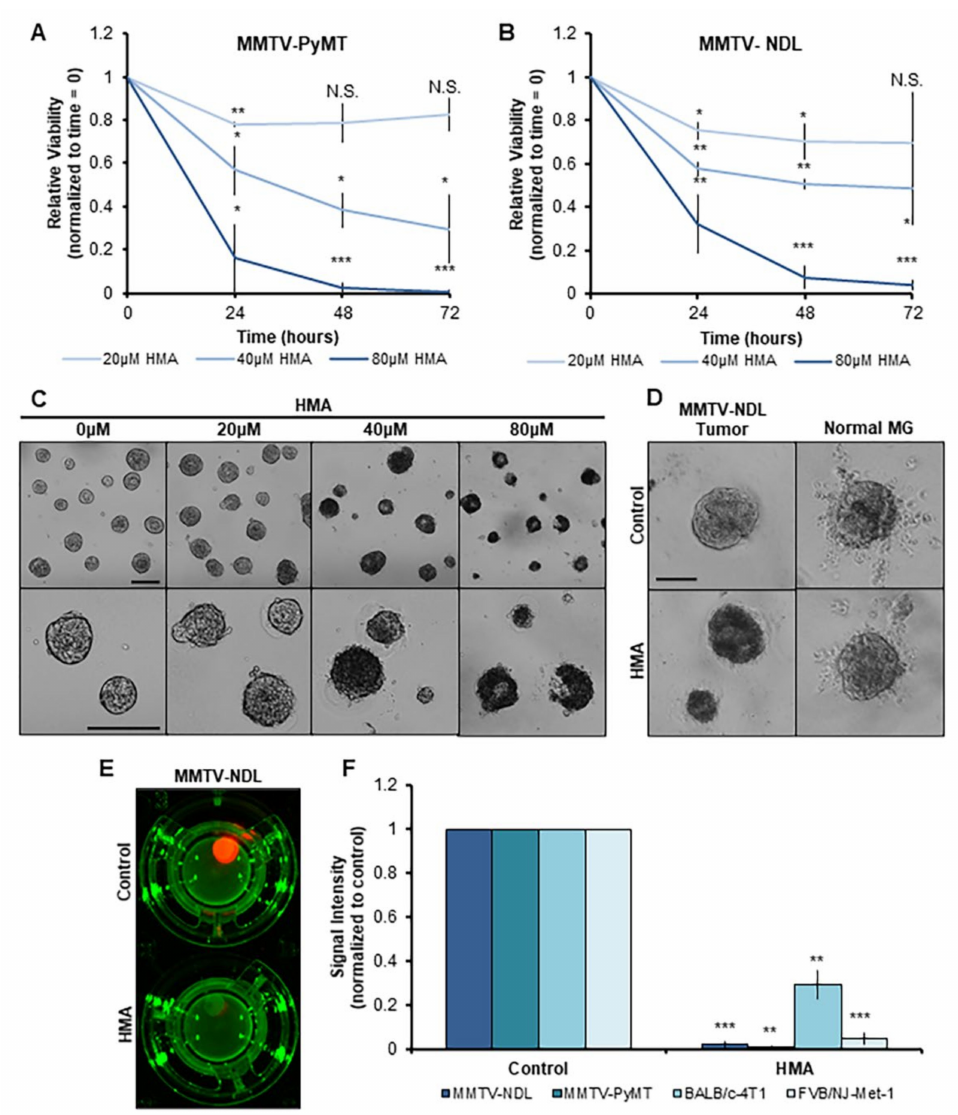
Figure 3. HMA impacts viability of mouse mammary tumor tissues ex vivo. ( A – D ) Organoids dissociated from MMTV-PyMT ( A , C ) or MMTV-NDL ( B , D ) mouse mammary tumors were admin- istered increasing concentrations of HMA for 72 h. ( A , B ) RealTime Glo viability signal intensity was measured every 24 h and normalized to pretreatment organoid viability (time = 0) and vehicle control. Data encompass three biological tumor replicates from independent mice. ( C ) Representative images of MMTV-PyMT organoids following 72 h treatment are displayed. Scale bar = 200 µ m. ( D ) Organoids derived from MMTV-NDL tumor ( left ) and normal mammary gland ( right ) were treated with 40 µ M HMA or vehicle control for 48 h, and representative images are presented.